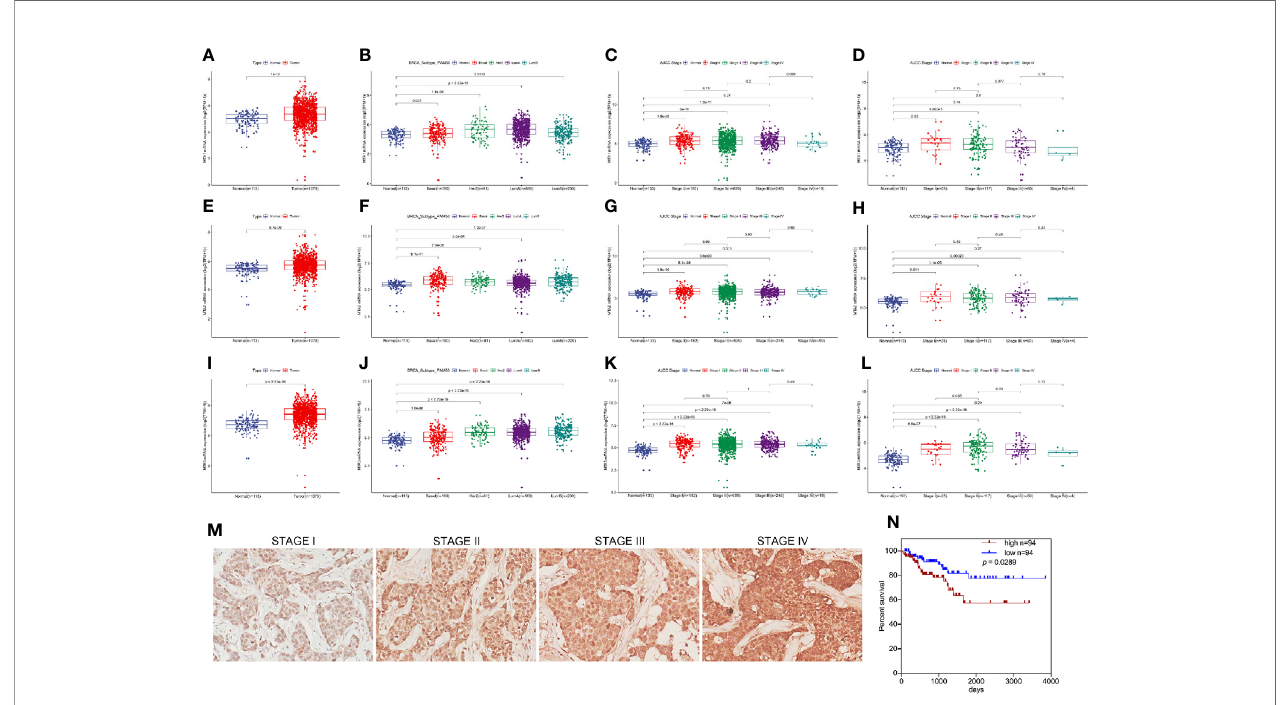
FIGURE 1 | MTA1 is a prognosis factor of luminal-b breast cancer. (1) mRNA level of MTA1-3 in breast cancer tissues and adjacent normal tissues from TCGA data (A, E, I) . (2) mRNA level of MTA1-3 in breast cancer tissues (TNBC, Her-2 type, Luminal_A and luminal-b) and adjacent normal tissues from TCGA data (B, F, J) . (3) mRNA level of MTA1-3 in different clinical stages breast cancer tissues and adjacent normal tissues from TCGA data (C, G, K) . (4) mRNA level of MTA1-3 in different clinical stages luminal-b breast cancer tissues and adjacent normal tissues from TCGA data (D, H, L) . (5) IHC of MTA1 in luminal-b breast cancer tissue sections, which showed higher MTA1 expression with higher clinical stage (p<0.01) (M, N) . (6) IHC showed the overall survival in high and low expression of MTA1 breast cancer groups, which revealed higher expression of MTA1 accompanied with worse prognosis (p=0.0289) (M, N) .